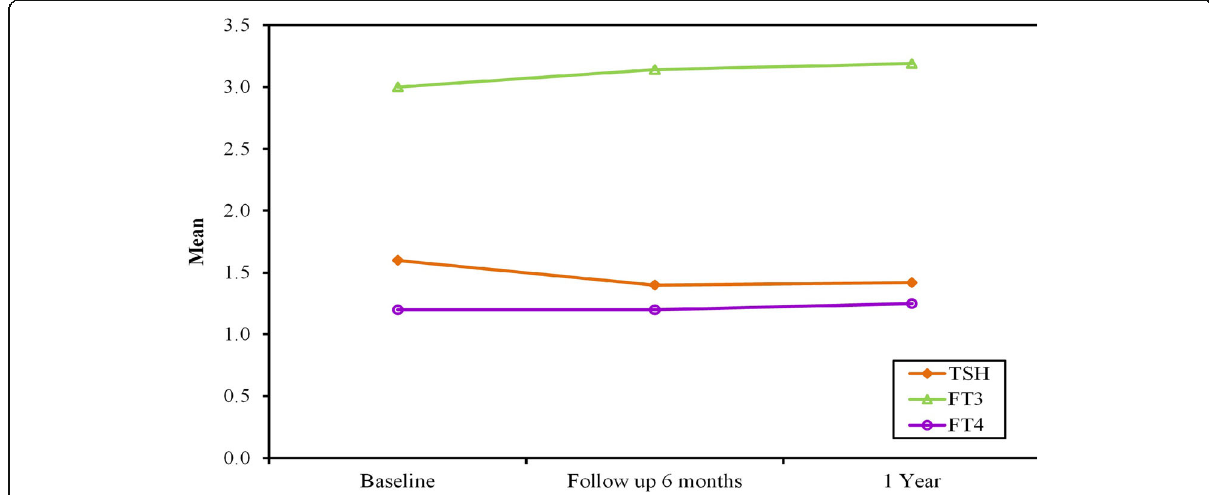
Fig. 2 Comparison between the whole group at baseline, 6-, and 12-month follow-up periods according to different thyroid profile parameters